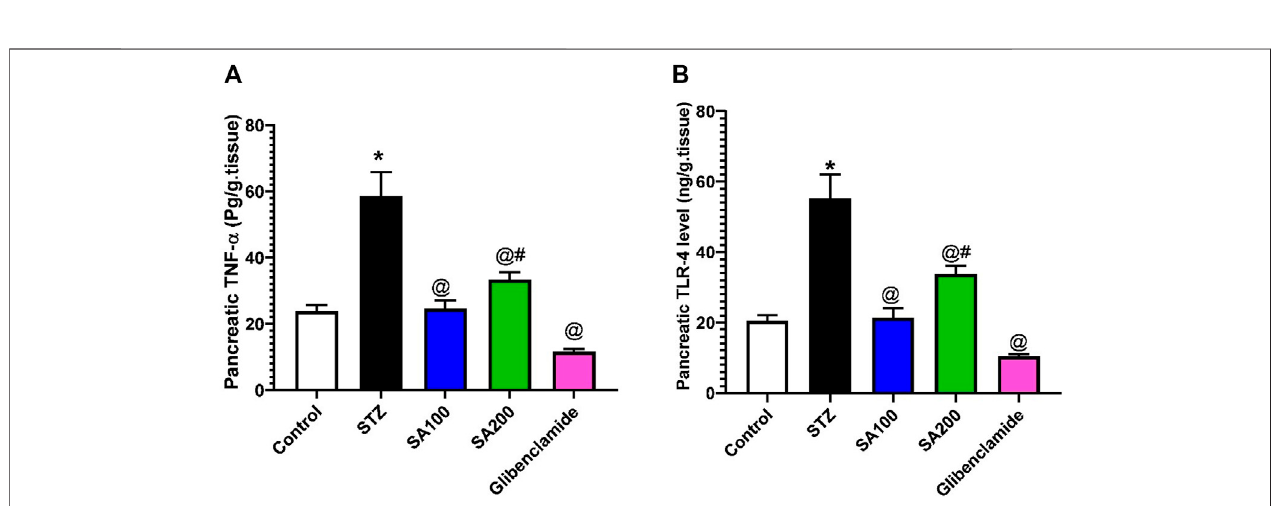
FIGURE7| Resultsfromtheoraladministrationoftheleafextractof S.aqueum (SA)onthelevelsofpancreatic (A) tumornecrosisfactor-alpha(TNF- α )and (B) toll- like receptor 4 (TLR-4) in STZ diabetic animals. Results are presented as mean ± SEM. *Signi fi cant difference related to normal control group, @ related to STZ diabetic rats, and # related to reference drug group, glibenclamide at p < 0.05 by One-Way ANOVA and Tukey ’ s post hoc test, n (cid:2) 6.